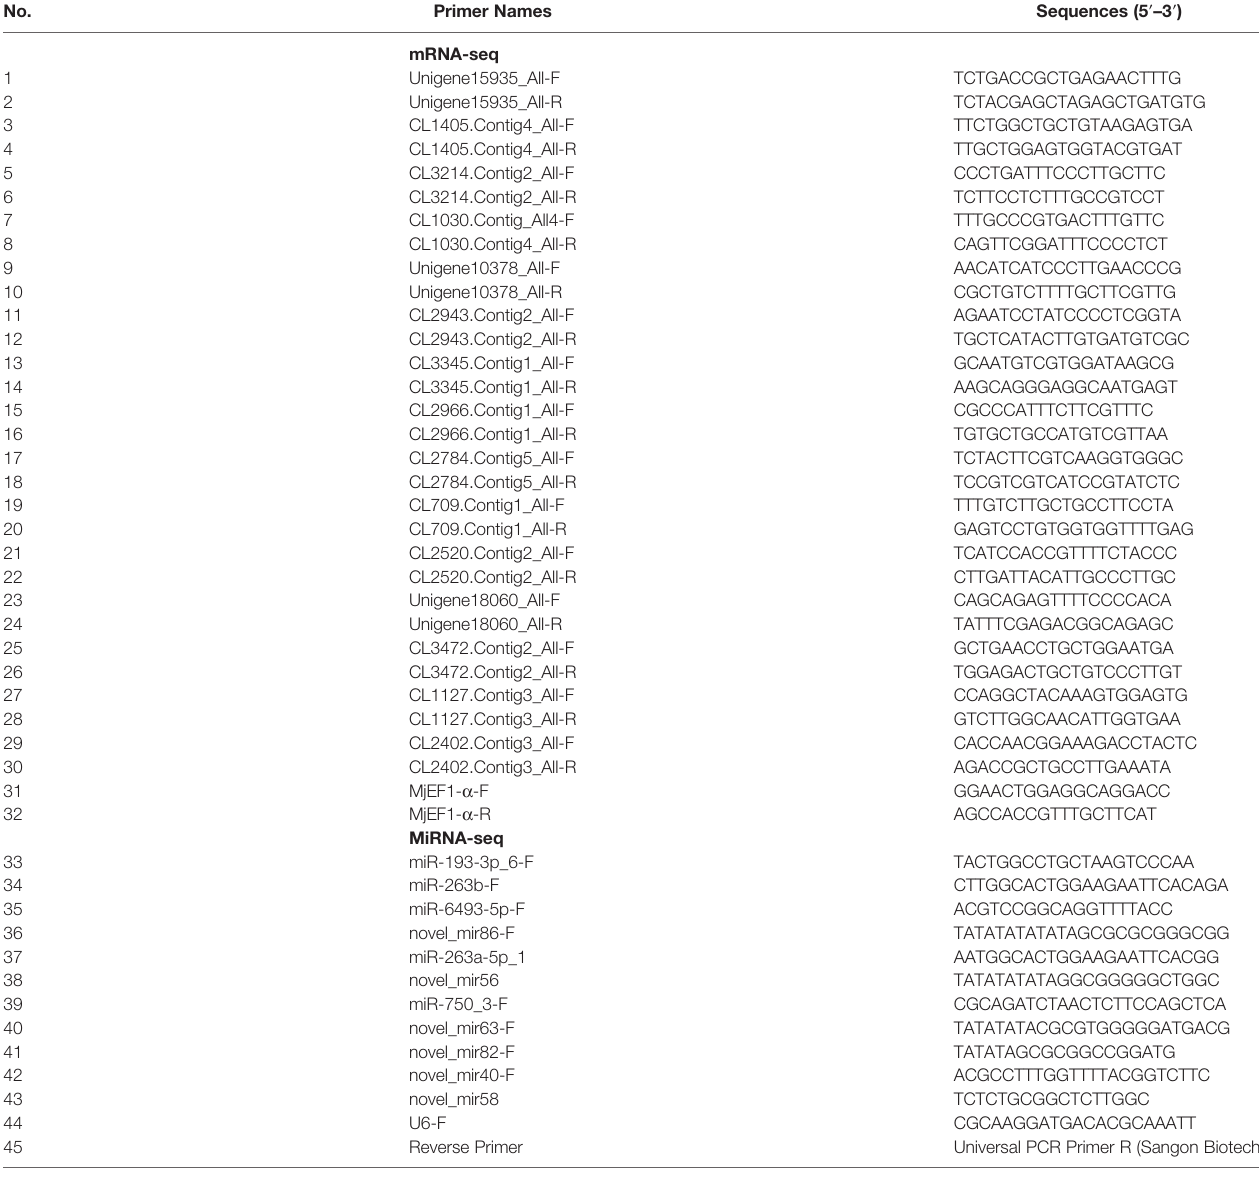
TABLE 1 | Details of the primer sequence used for